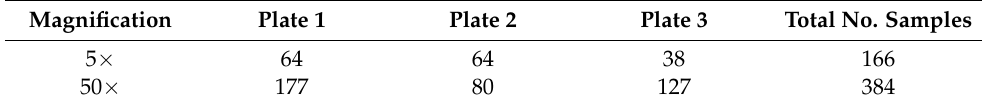
Figure 2. An illustration of the optical microscopy work flow showing the cross-ply laminate and the micrographs used for the analysis. Table 2. Sample matrix showing the number of micrographs available for the magnifications used.